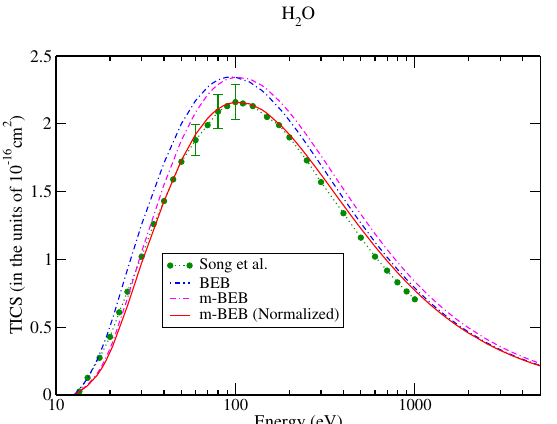
Figure 5. Total ionization cross-sections of water: dots with circles, recommended data of Song et al. [74]; BEB model, dashed dotted curve, m-BEB model, dashed dotted curve; line curve, normalized m-BEB model.